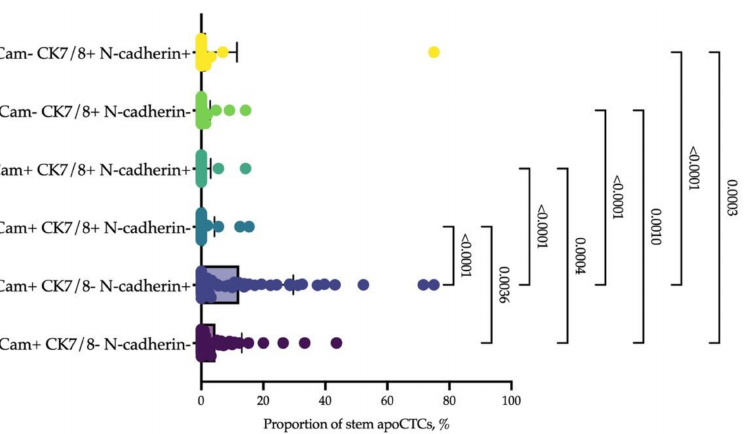
Figure 7. Epithelial and mesenchymal markers of stem apoCTCs. Each point represents the propor- tion of CD44+CD24 − apoCTCs (considered as 100%) with epithelial features, EpCAM and cytokeratin 7/8 (CK7/8), and mesenchymal features (N-cadherin) in each breast cancer